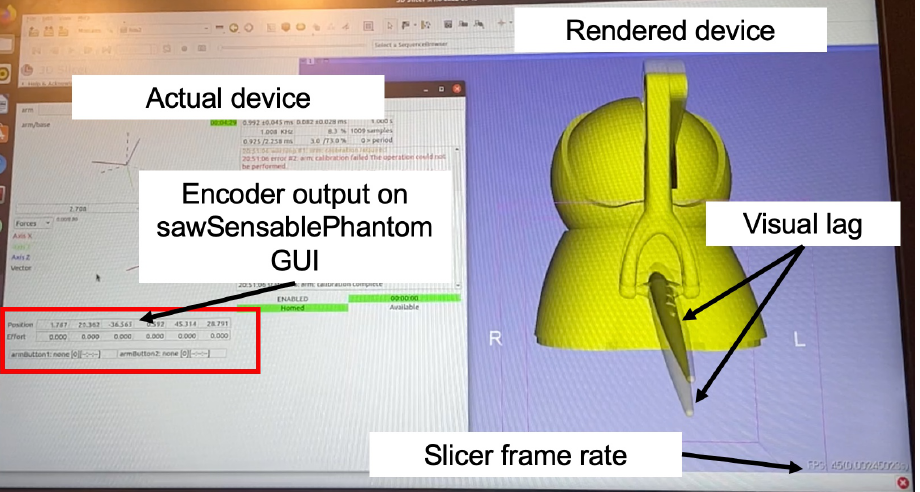
Figure 6. Screenshot from experiment recording: displaying the actual device encoder reading, rendered device, and an example of the visual lag used to qualify movement